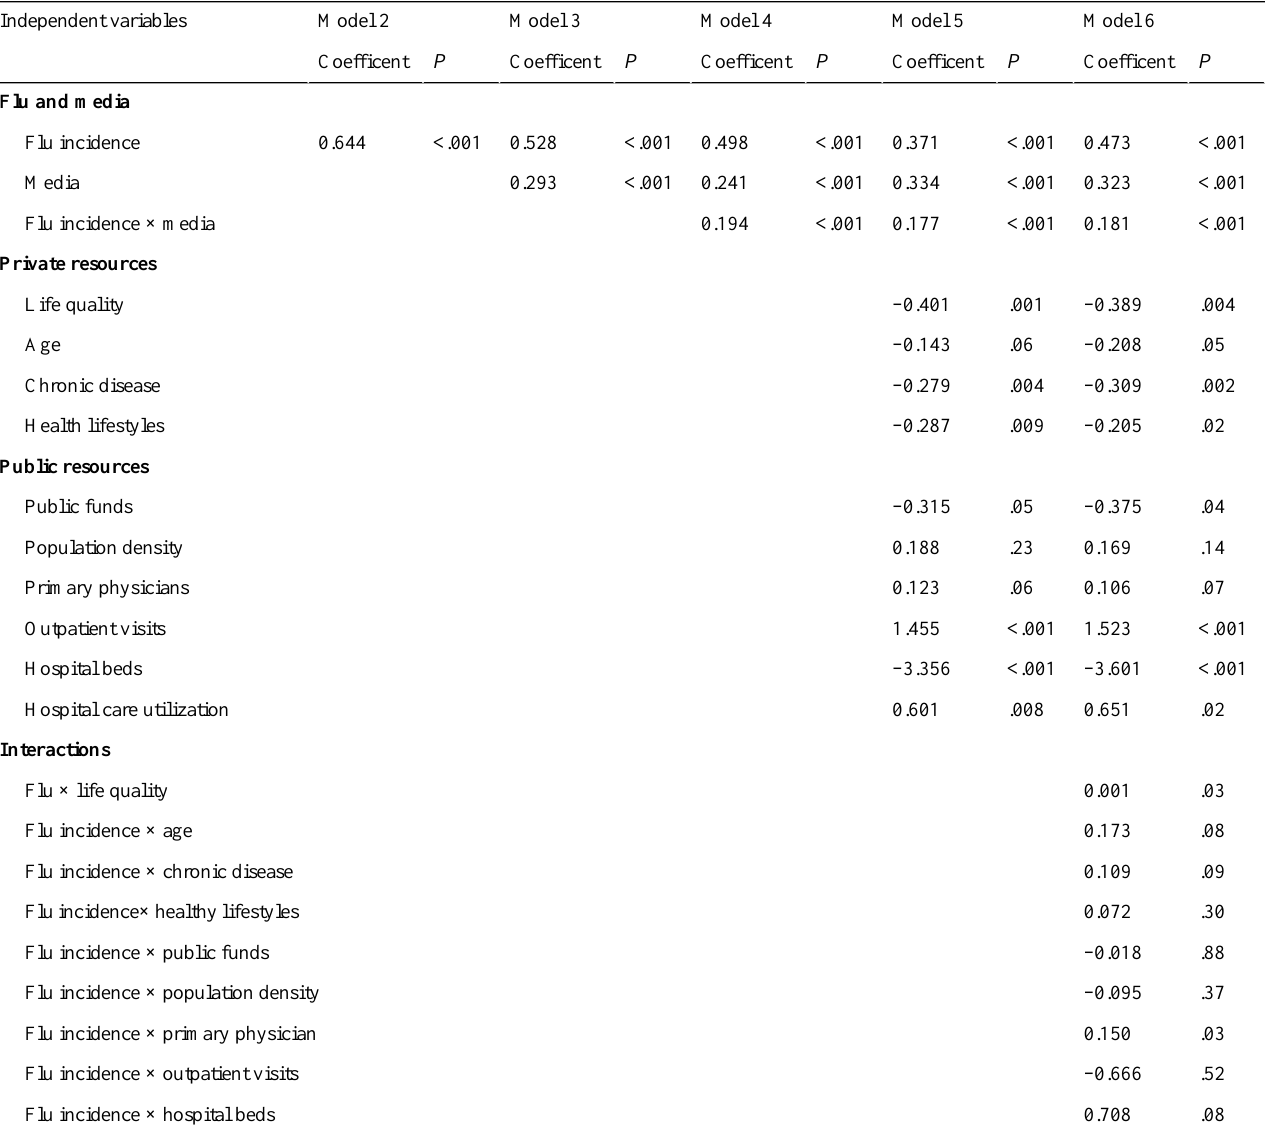
Model 6Model 5Model 4Model 3Model 2Independent